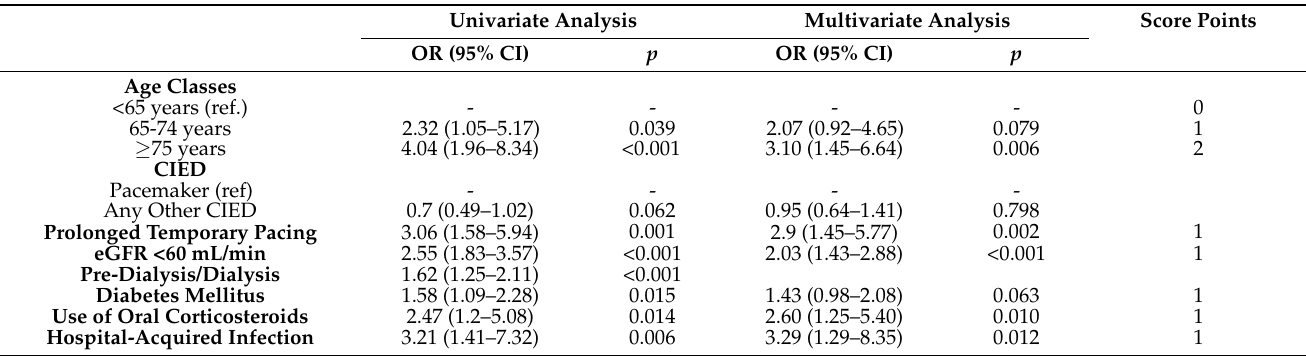
Table 4. Logistic regression analysis for clinical events